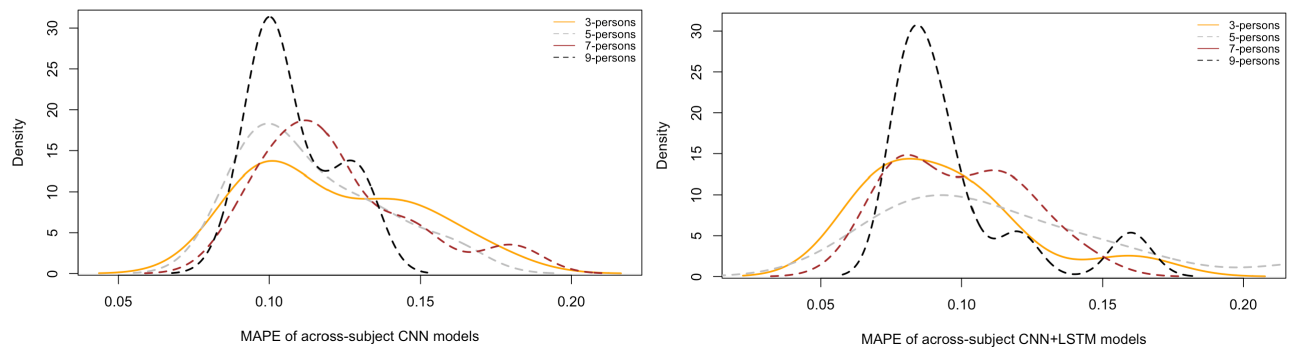
Figure 11. Comparisons of the test Mean Absolute Percentage Error (MAPE) of the across-subject models grouped by the type of architecture which is the single convolutional neural network (CNN) and the convolutional/recurrent neural network